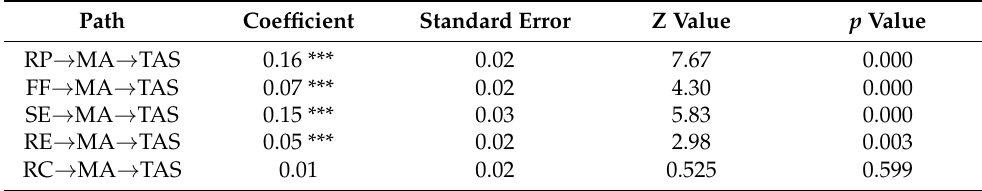
Table 7. Significance testing of mediation effects (standardized).